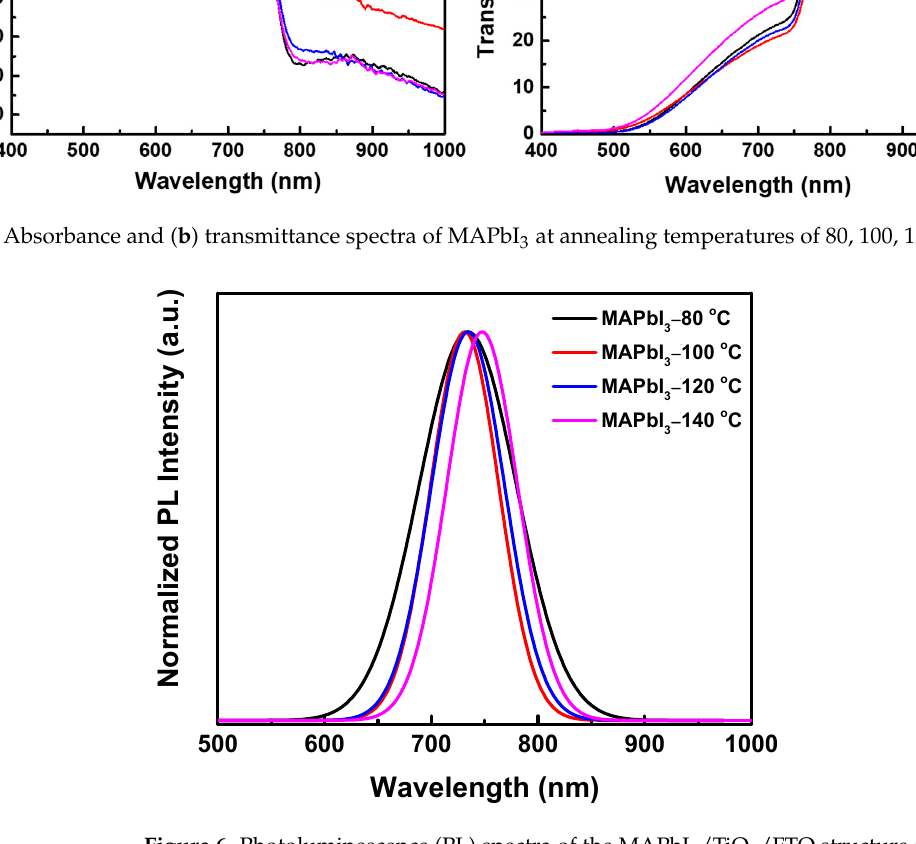
Figure 6. Photoluminescence (PL) spectra of the MAPbI 3 /TiO 2 /FTO structure at annealing tempera- tures of 80, 100, 120, and 140 °C.